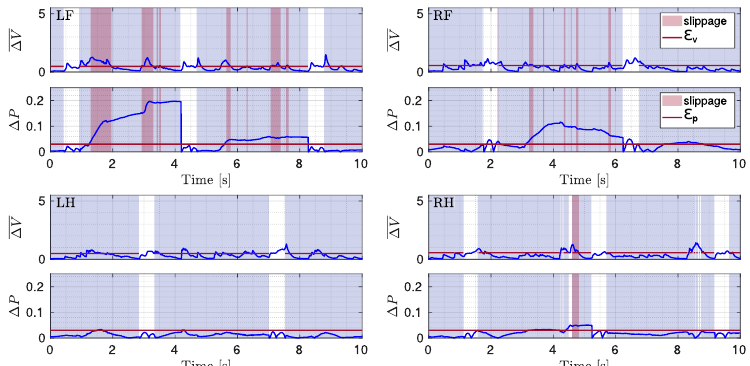
Figure 11. Plots of ∆ V and ∆ P (blue) with respective thresholds (red line) illustrated for the four legs (LF, RF, LH, RH) during a crawl gait. The gray shaded area shows stance phases and the red shaded area marks slippage.